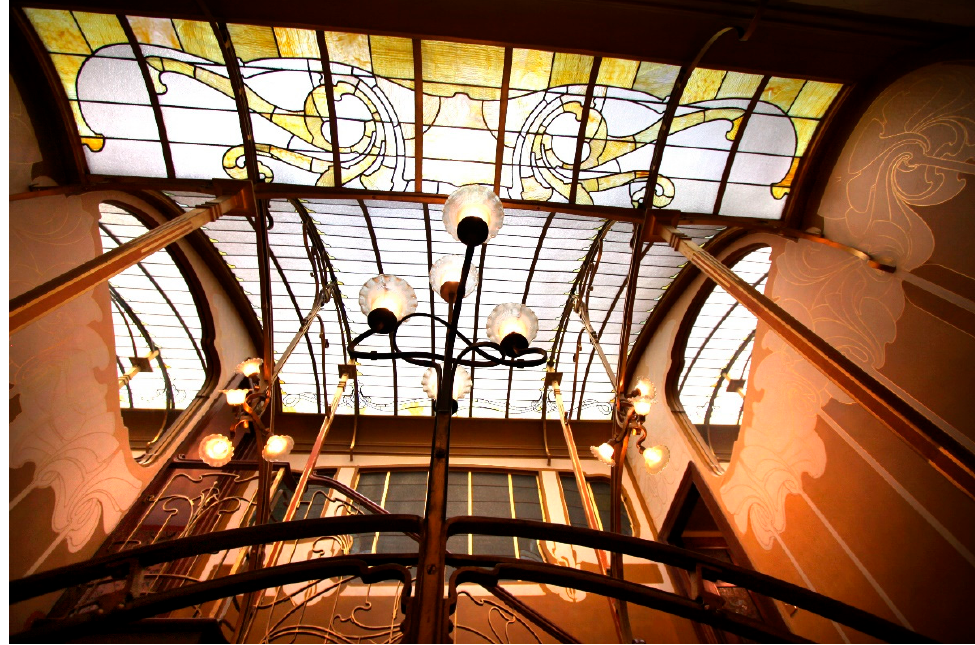
Figure 6. The effect of verticalism and biomorphic interior design observed in the Horta House.